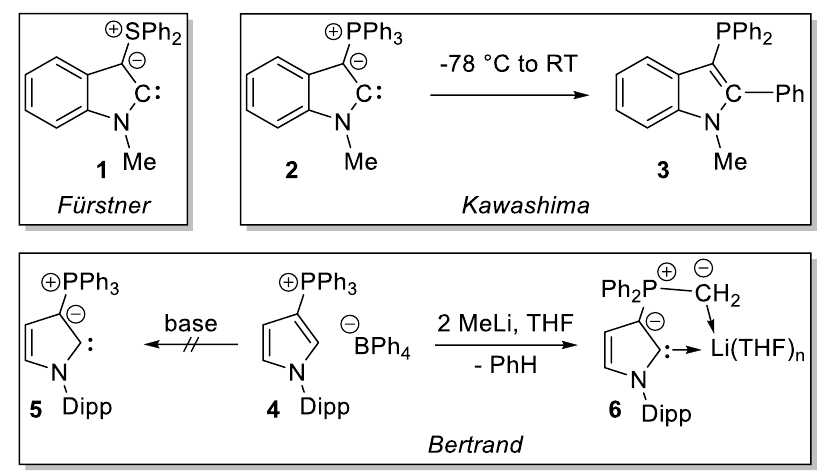
Figure 2. Attempts to isolate CAYCs (Dipp = 2,6-diisopropylphenyl) [25–27].